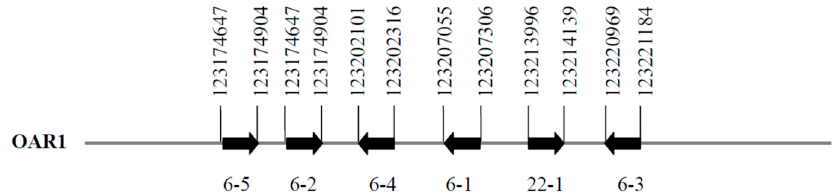
Figure 1. Location of sheep genome region that is homologous to KRTAP22-1 , together with five other previously identified KRTAPs on sheep chromosome 1. Horizontal arrow bars represent the coding regions of KRTAPs and the arrowheads indicate the direction of transcription. The numbers below the horizontal arrow bars indicate the name of the respective KAP gene (e.g., 6-5 represents KRTAP6-5 ). The nucleotide positions refer to